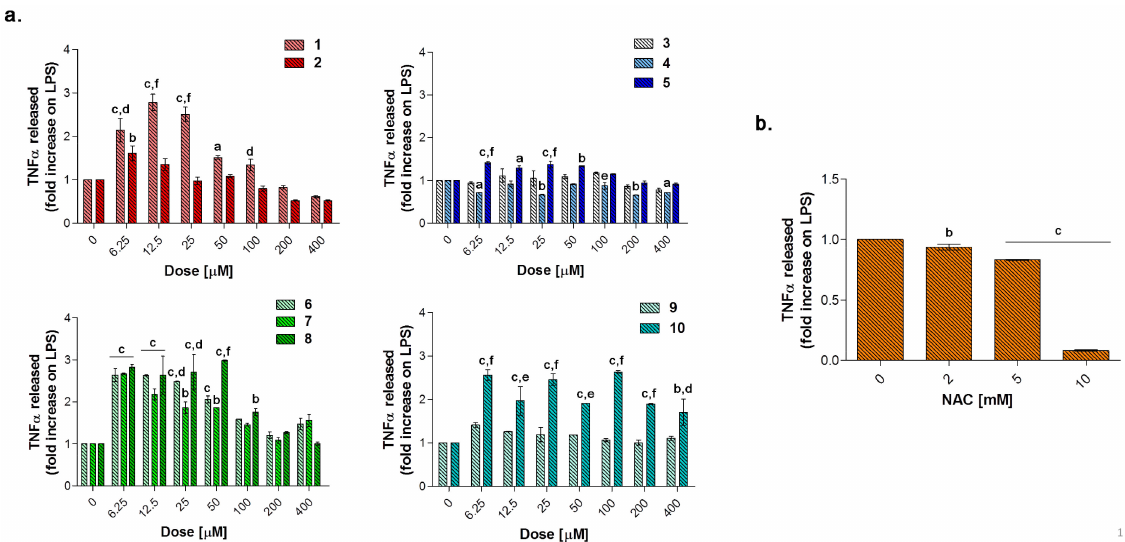
Figure 9. Tumor necrosis factor alpha (TNF- α ) released from LPS-stimulated (0.1 µ g/mL) RAW 264.7 mouse macrophages in the presence of increasing concentrations (0–400 µ M) of compounds 1 – 10 ( a ) and NAC ( N -acetyl cysteine) (0–10 mM) ( b ) after 24 h. Data shown are the means ± S.D. of six replicates and are expressed as the fold increase of the TNF- α released (pg/mL) from cells stimulated with 0.1 µ g/mL LPS alone for 24 h (0 µ M) set as 1. (a = p < 0.05 between compounds or NAC and cells exposed to LPS alone; b = p < 0.01 between compounds or NAC and cells exposed to LPS alone; c = p < 0.001 between compounds or NAC and cells exposed to LPS alone; d = p < 0.05 between compounds at the same concentration; e = p < 0.01 between compounds at the same concentration; f = p < 0.001 between compounds at the same